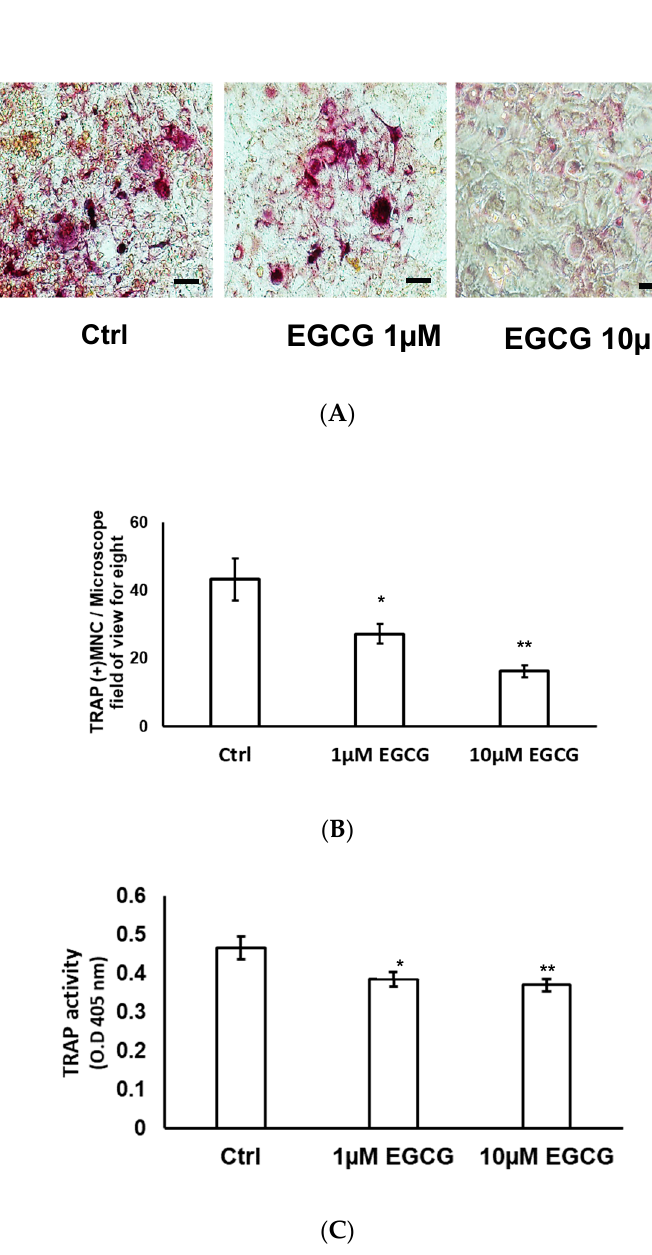
Figure 4. EGCG inhibited osteoclast differentiation of RAW 264.7 cells cocultured with ST2 cells. Coculture cells were seeded in 48-well plates containing α -MEM medium plus 10% FBS, 0.1 µmol/L 1,25(OH) 2 D 3 , and 0.1 µmol/L dexamethasone (DEX). In RAW 264.7 cells, the number of TRAP-positive osteoclasts was reduced by EGCG in a dose-dependent manner ( A ). After quantification, EGCG effectively suppressed the number of multinucleated TRAP-positive cells by 21% at 1 µmol/L ( p < 0.05) and 91% at 10 µmol/L ( p < 0.001) ( B ). EGCG at concentrations of 1 and 10 µmol/L dose-dependently reduced the TRAP activity by 17% ( p < 0.05) and 21% ( p < 0.01) in RAW 264.7 cells ( C ).